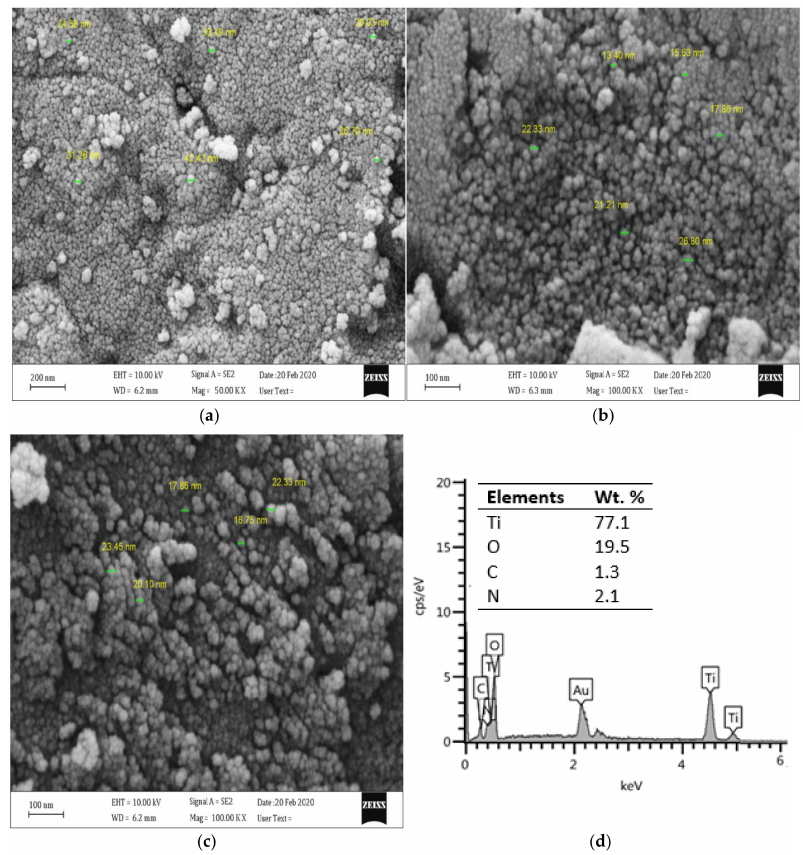
Figure 6. FESEM/EDX of the synthesized photocatalysts ( a ) L-Asparagine (2 wt.%)-TiO 2 ( b ) L- Methionine (1.5 wt.%)-TiO 2 ( c ) L-Histidine (2 wt.%)-TiO 2 ( d ) EDX spectrum of L-Histidine (2 wt.%)-TiO 2 . 3.3. Statistical Analysis and Modeling for Photodegradation of OTC and COD by L-Histidine (2 wt.%)-TiO